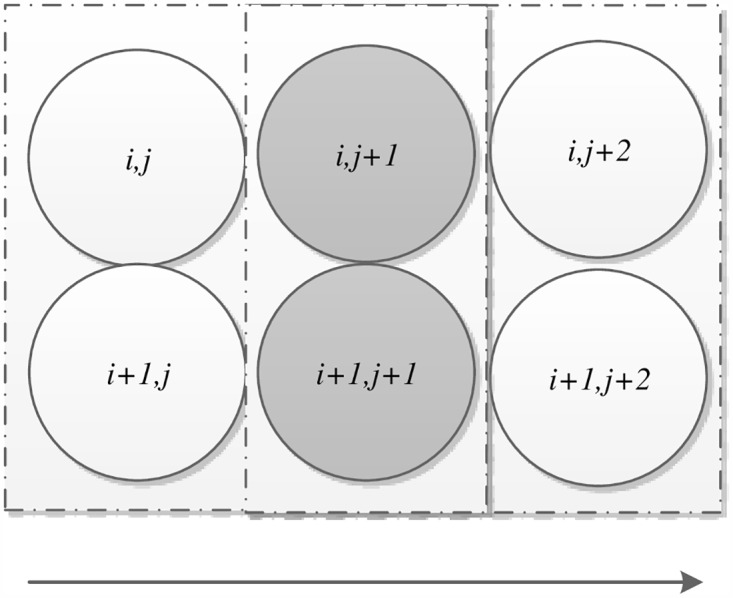
The intersected block.